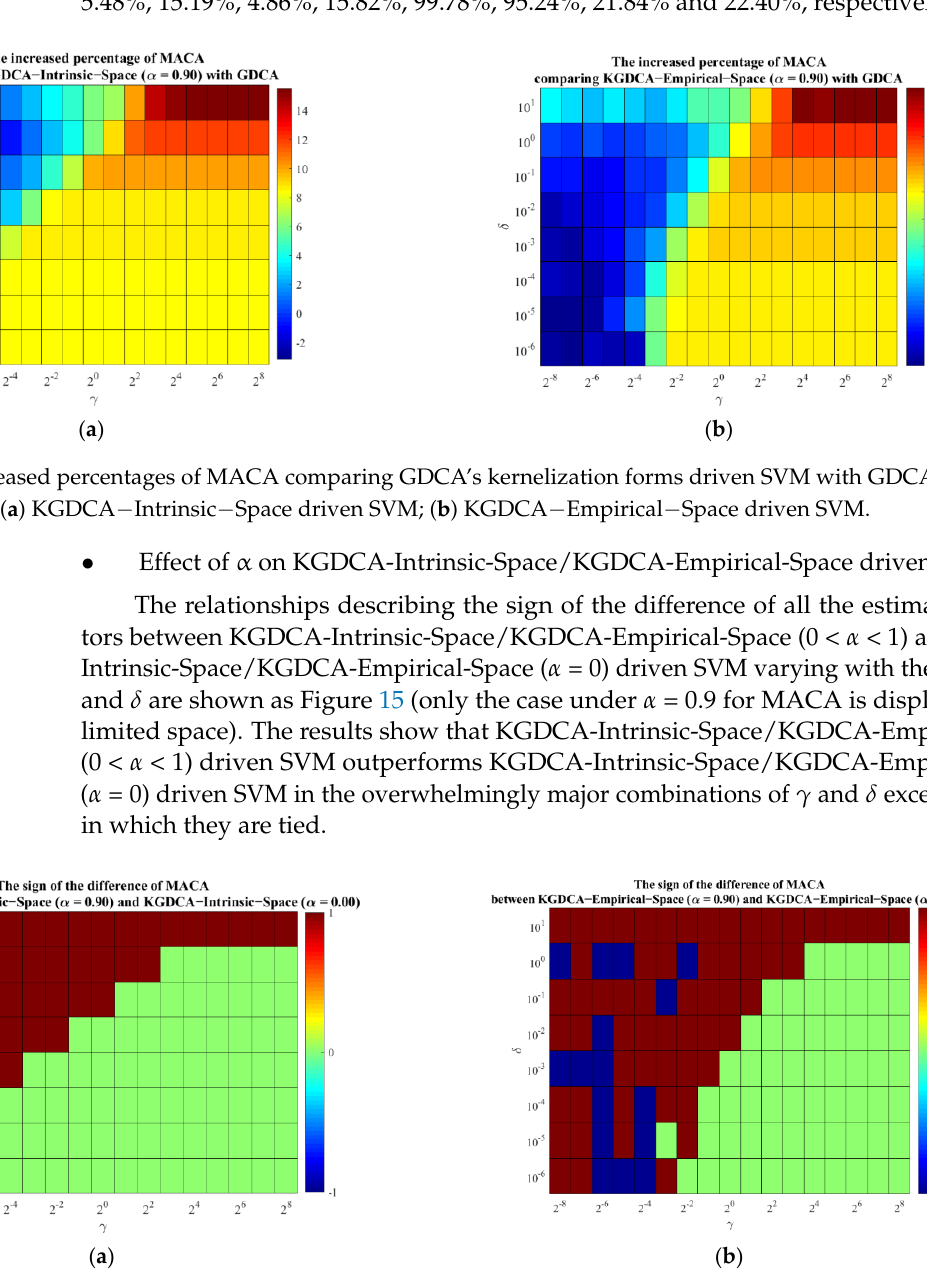
18 of 27 Figure 13. Comparisons of MACA between GDCA’s kernelization forms driven SVM and original SVM when α = 0.9. ( a ) KGDCA − Intrinsic − Space driven SVM; ( b ) KGDCA − Empirical − Space driven SVM.